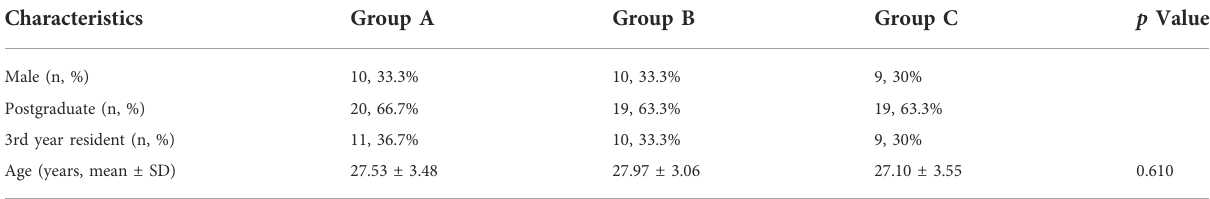
TABLE 2 Baseline characteristics of participants.